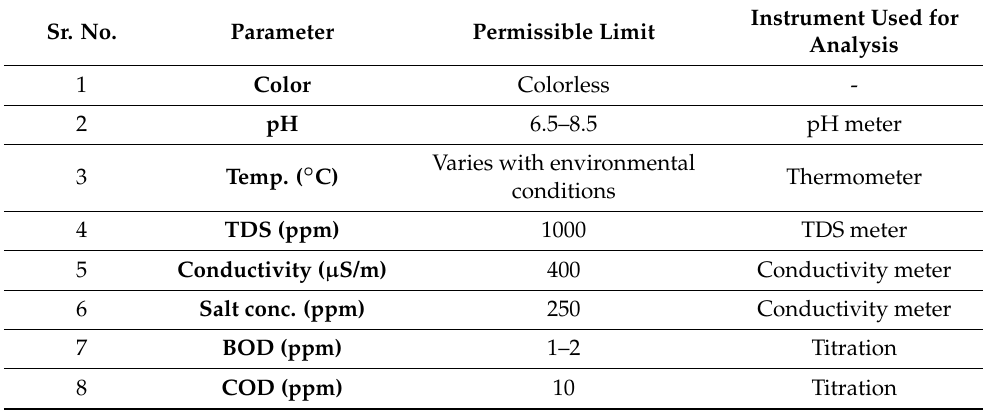
Table 4. Standard limits of different parameters in potable water.